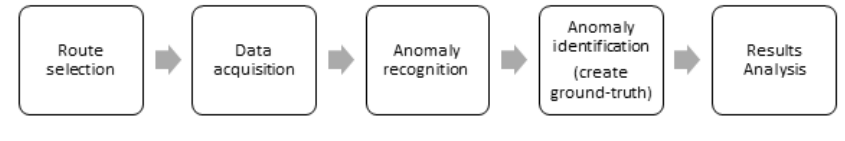
Figure 5. Evaluation